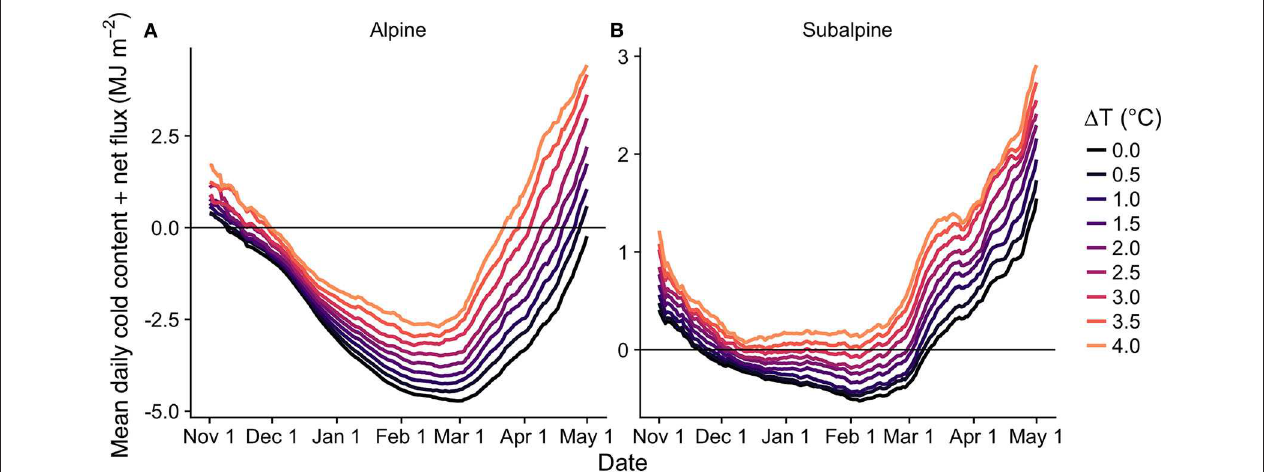
FIGURE 7 | Mean daily cold content plus net flux (i.e., the sum of the energy fluxes on the righthand side of Equation 1 plus the cold content added from snowfall) for the 1 T perturbations in the alpine (A) and subalpine (B) . The black horizontal line at 0 MJ m − 2 represents cold content being equal to the net fluxes in magnitude. Colored lines above the zero line indicate that the net fluxes were, on average, greater in magnitude than snowpack cold content, meaning melt could occur. Note: subplots have different y-axis ranges in order to see line spread in subalpine.